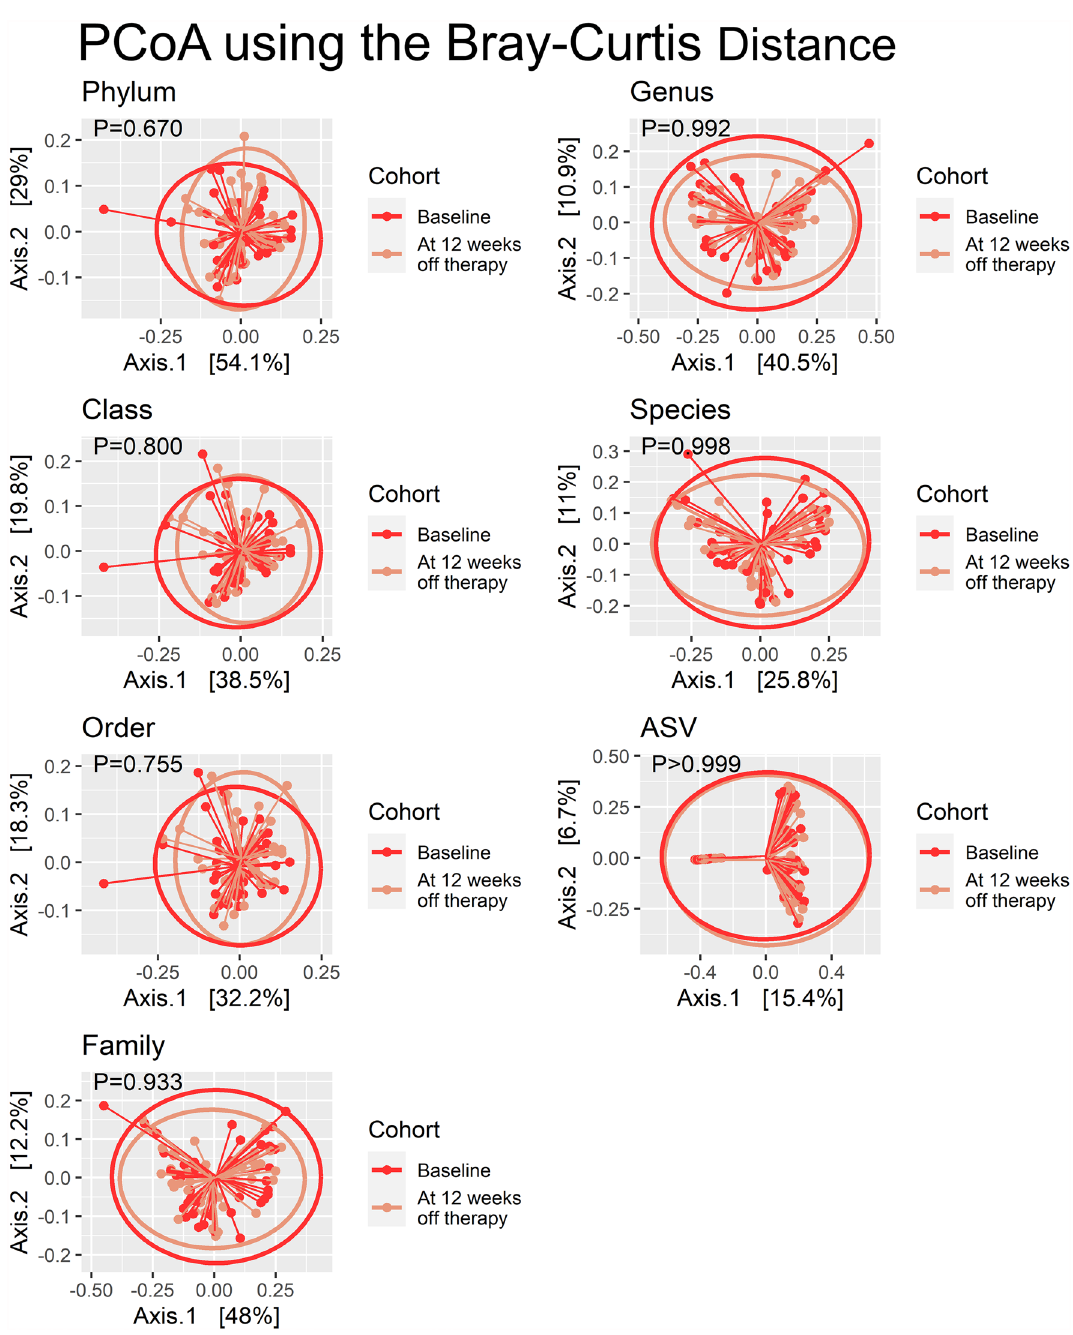
Figure 2. Principal coordinate analyses for the microbial compositions measured before and shortly after (12 weeks) eradication of hepatitis C virus